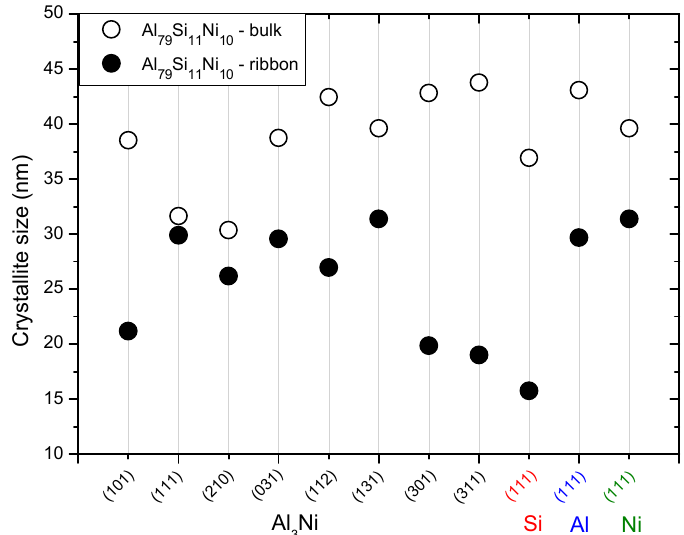
Figure 5. Crystallite size of different phases of Al 79 Si 11 Ni 10 in bulk and melt-spun ribbon form. The refinement of the structure is evident for the melt-spun ribbons, extrapolated from the lower crystallite size for all phases.